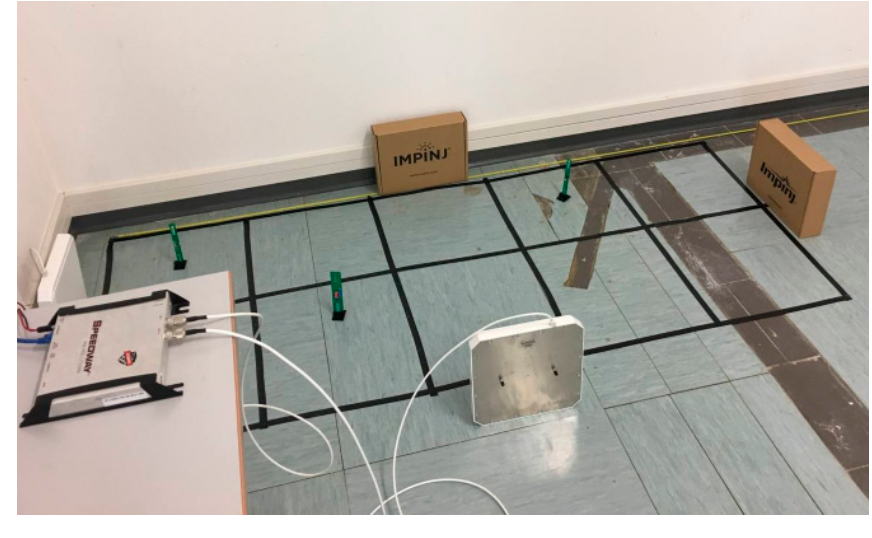
Figure 10. Preliminary test bench.